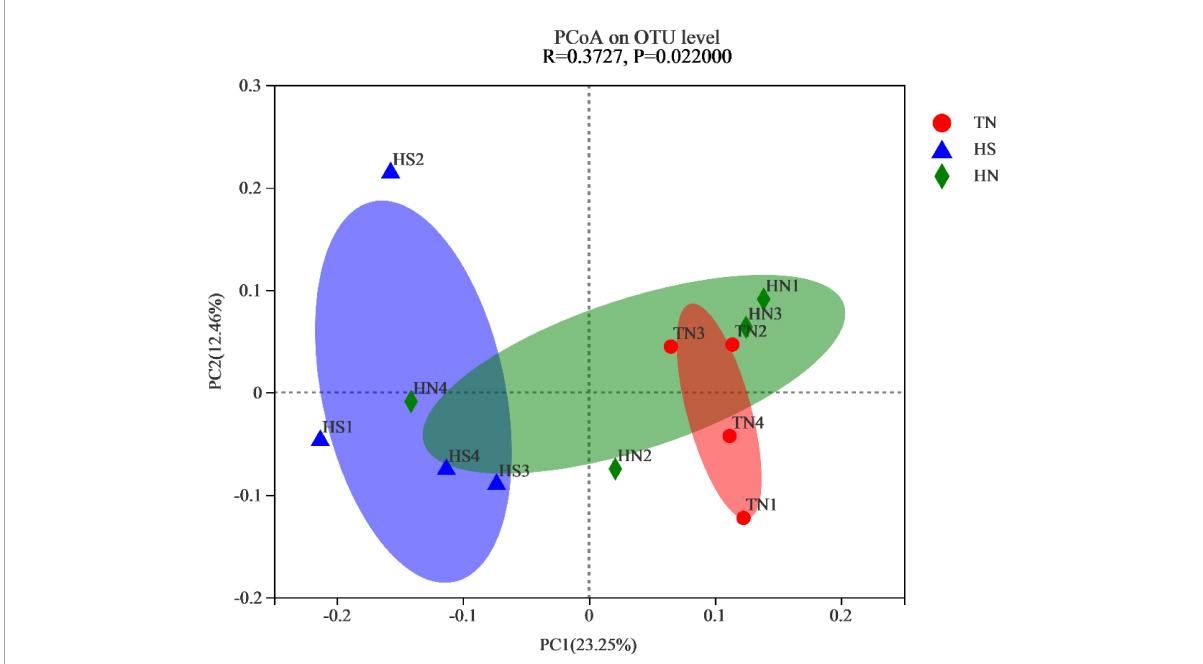
FIGURE2 Principal coordinate analysis (PCoA) plot based on OTU abundance. TN: the basal diet, thermoneutral condition ( n = 4); HS: the basal diet, heat stress environment ( n = 4); HN: the basal diet supplemented with 800 mg/kg NA ( n = 4).